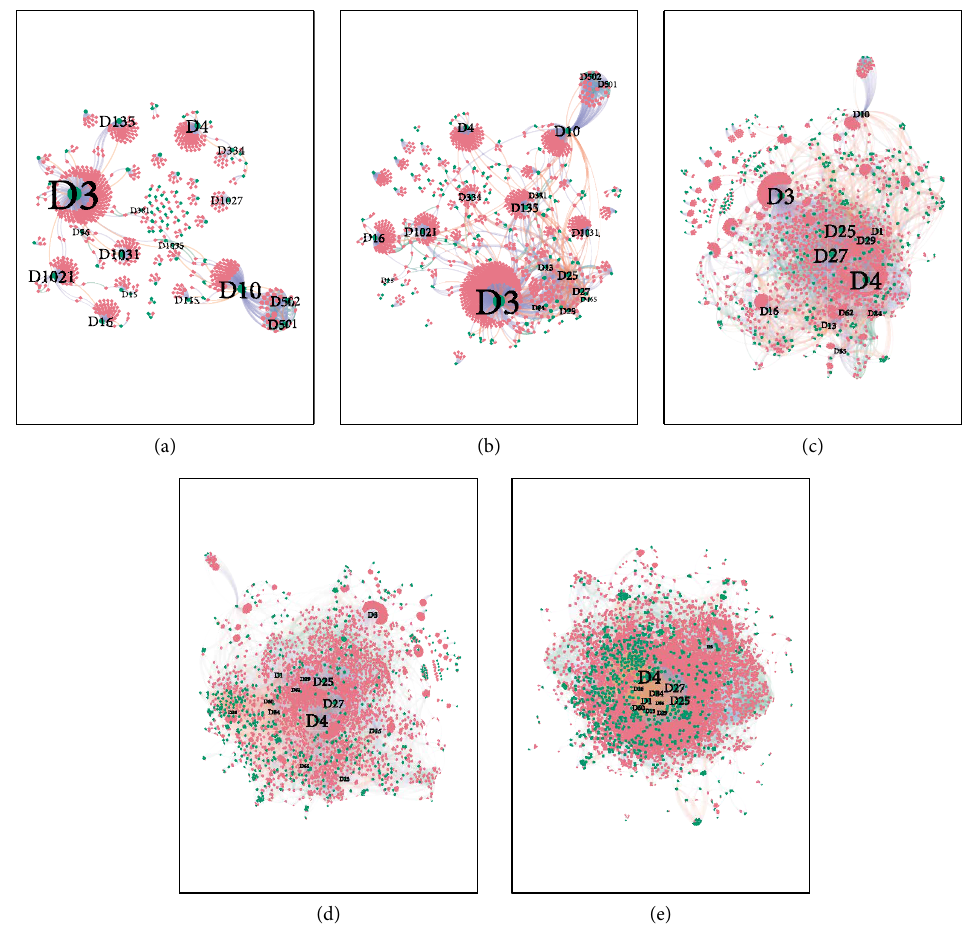
Figure 6: The overall networks in different stages. (a) 1997, (b) 2002, (c) 2007, (d) 2012, (e) 2017.